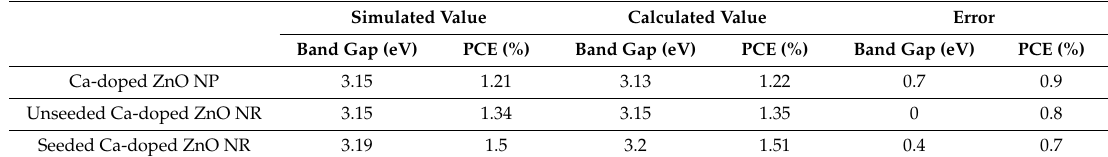
Table 1. Comparison between simulated and calculated values.